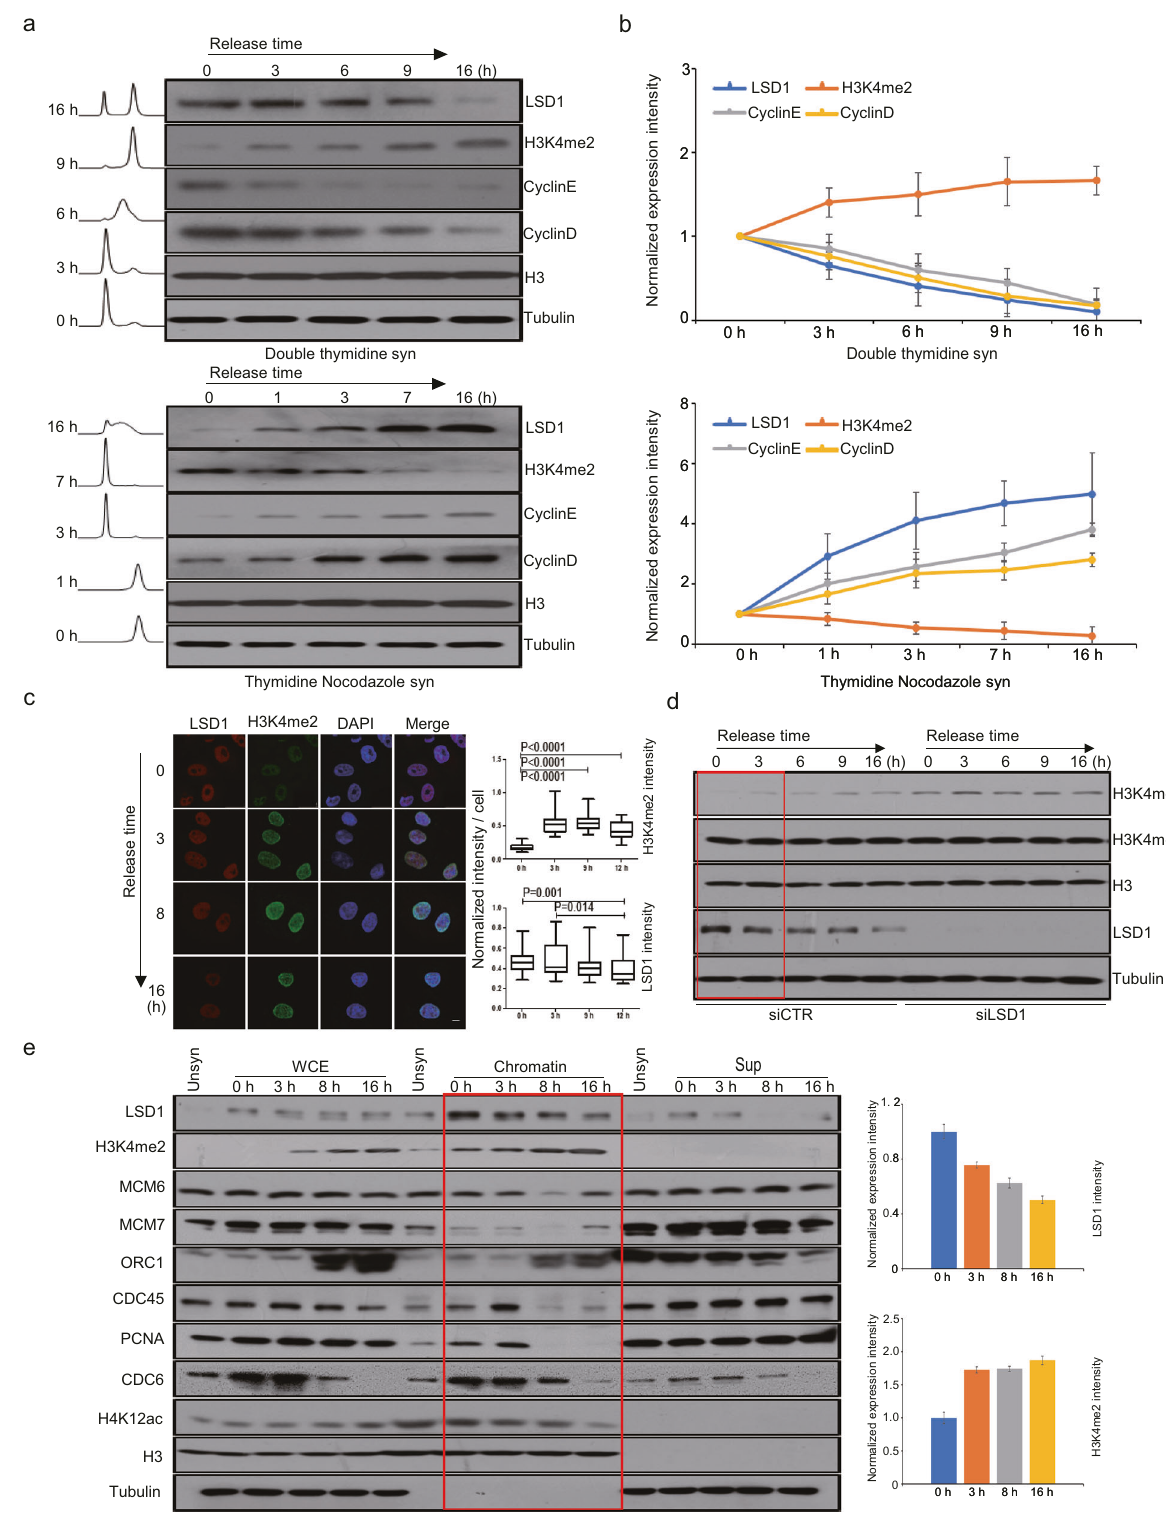
by fl ow cytometry after EdU conjugation to Alexa Fluor 647 and propidium iodide (PI) staining. Knockdown of LSD1 was associated with a decreased number of cells in S phase (Fig. 3a and Supplementary Fig. S1c), suggesting a role for LSD1 in either defective S-phase progression, G 1 arrest or accelerated progression Signal Transduction and Targeted Therapy (2022)